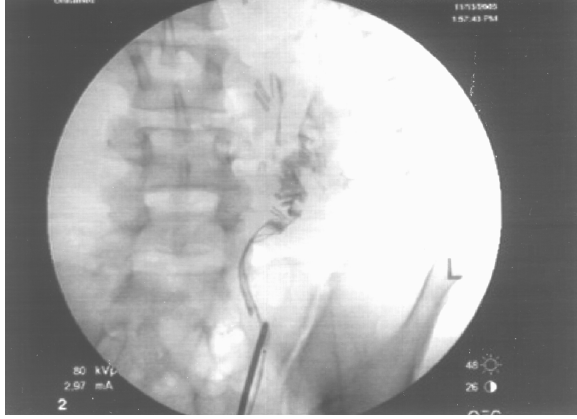
Figure 2 – Left retrograde injection of contrast medium demonstrating extravasation into the